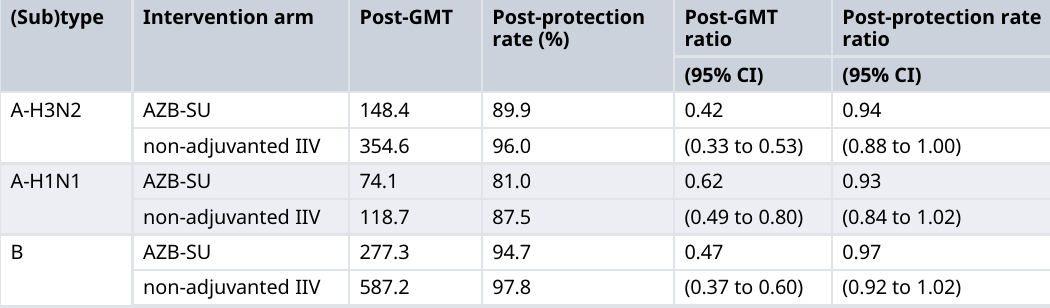
Table 2. Antibody and clinical protection levels for Trial 07, performed in the